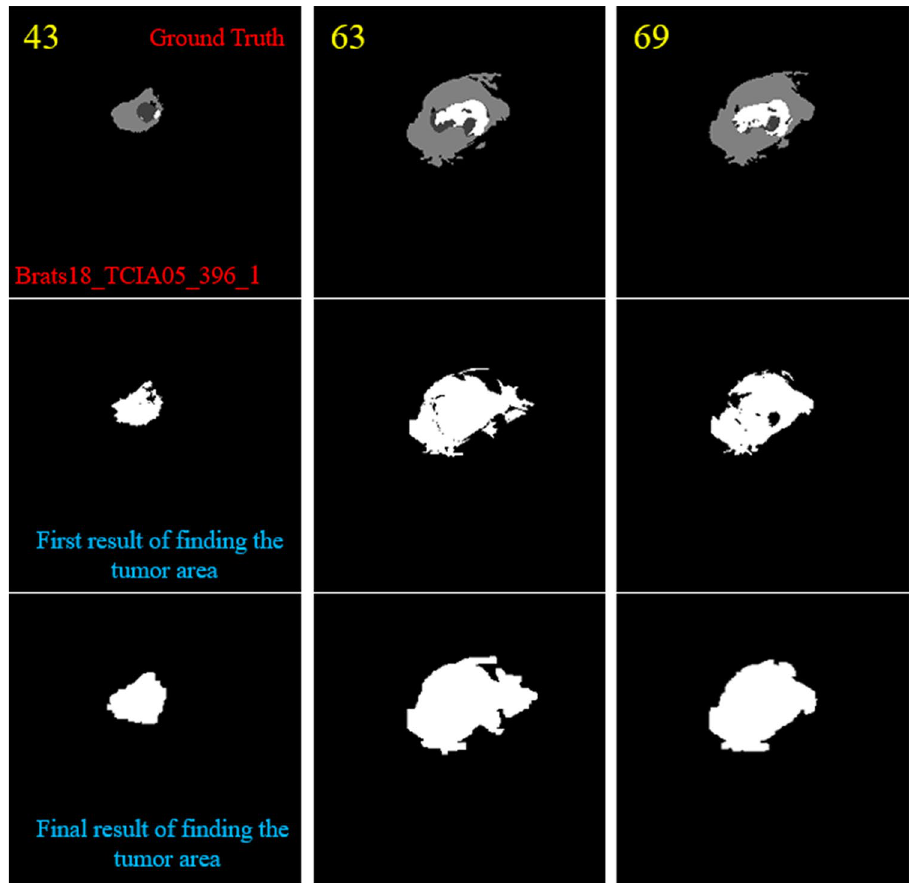
Figure 7. Two examples of finding the tumor object (expected area) and its corresponding center location and applying morphological filters to enlarge the tumor regions. The first row indicates the ground-truth images. The second row demonstrates the tumor object. The third row shows the enlarged tumor objects obtained in the second row. The yellow color in the top left corner indicates the slice